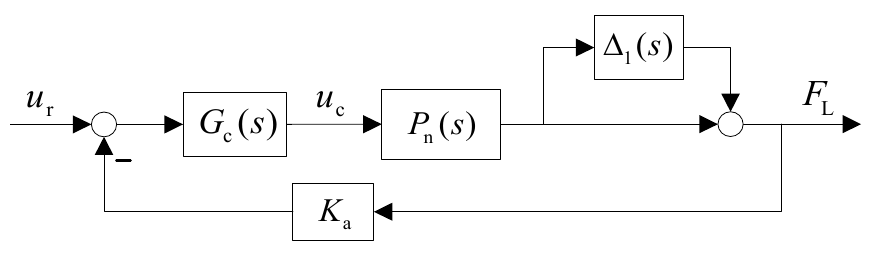
Figure 8. Equivalent structure of the outer loop.